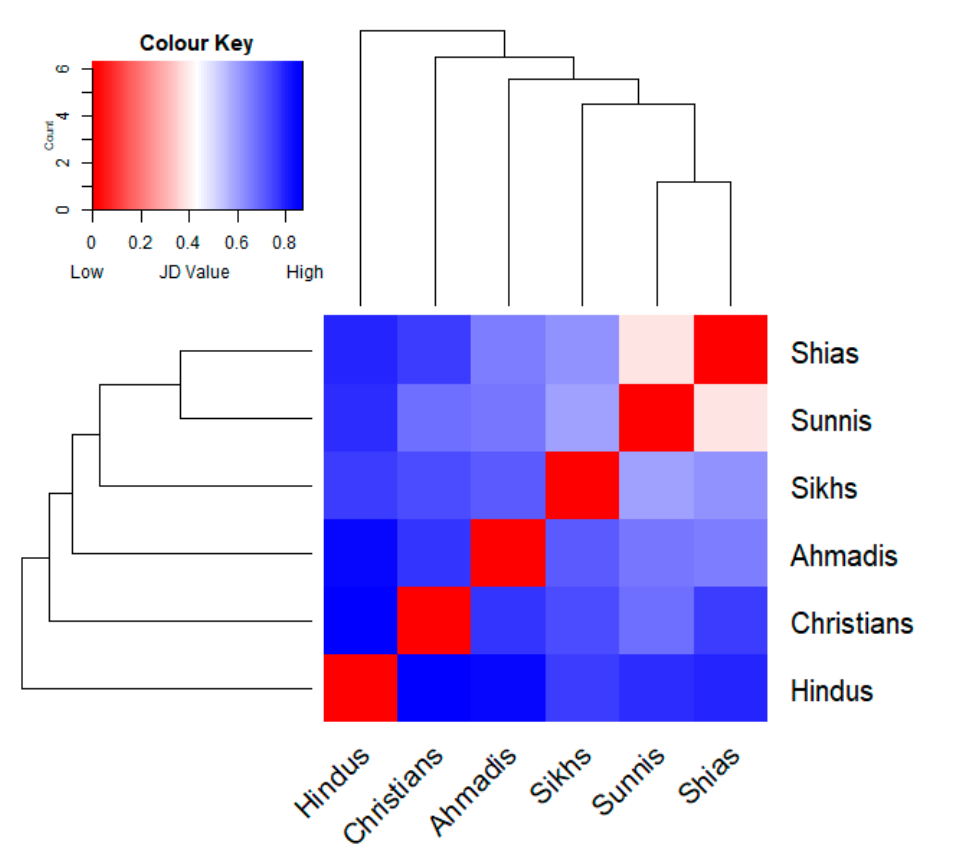
Figure 10. Hierarchical clustering tree coupled with heat map depicting Jaccard Dissimilarity Indices calculated by comparing the actual food utilizations of the recorded wild food plants among the six considered groups.